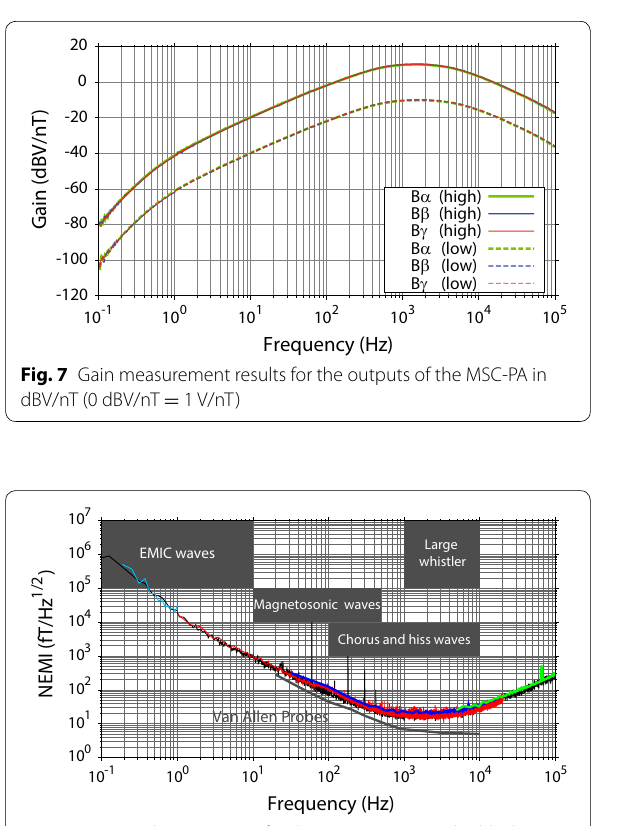
Fig. 8 Measured NEMI curves for the B γ component. The black curve is the laboratory experiment result on the ground. The light blue and red curves were obtained from the WFC observed on March 19, 2017, from 01:01 to 01:37 and 02:19 to 02:34 UT, during which plasma wave activity was very low. The blue and green curves were obtained from the OFA and HFA observed during 02:25 to 02:30 UT. The gray curve indicates the NEMI for the Van Allen Probes (Kletzing et al. 2013). Gray boxes are typical plasma wave spectra provided for reference. NEMI curves for the other axes showed almost the same